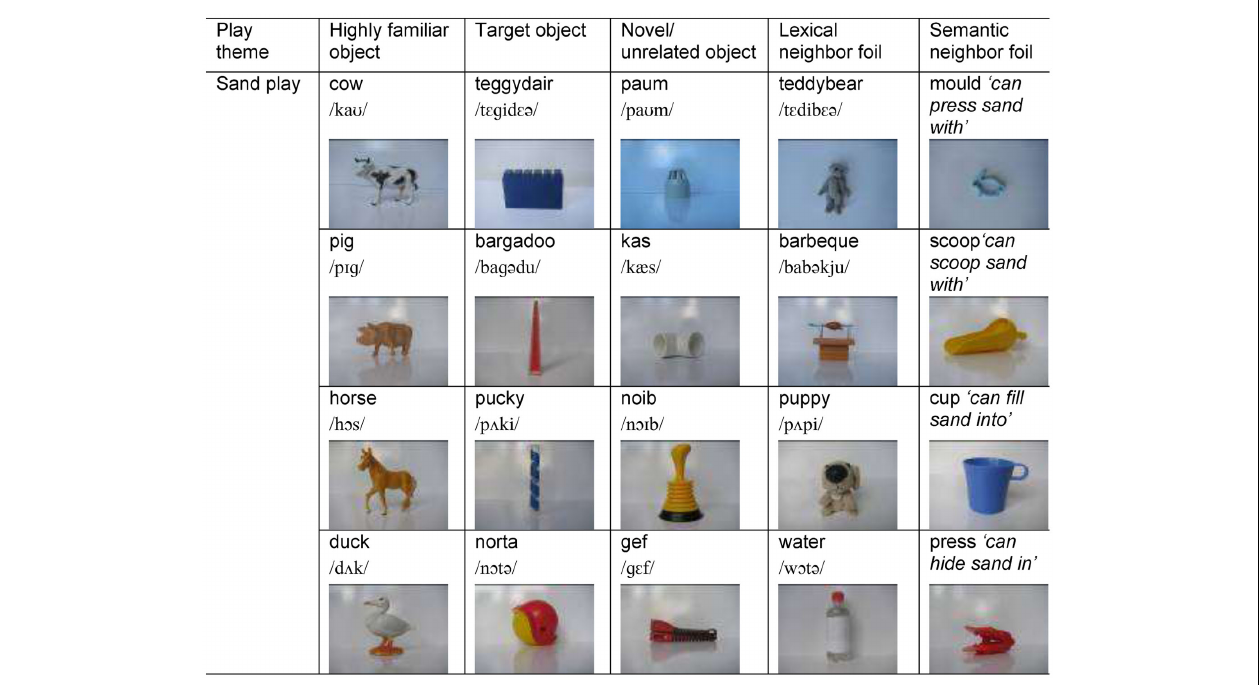
FIGURE 1 | Sand-play stimuli in theAFC